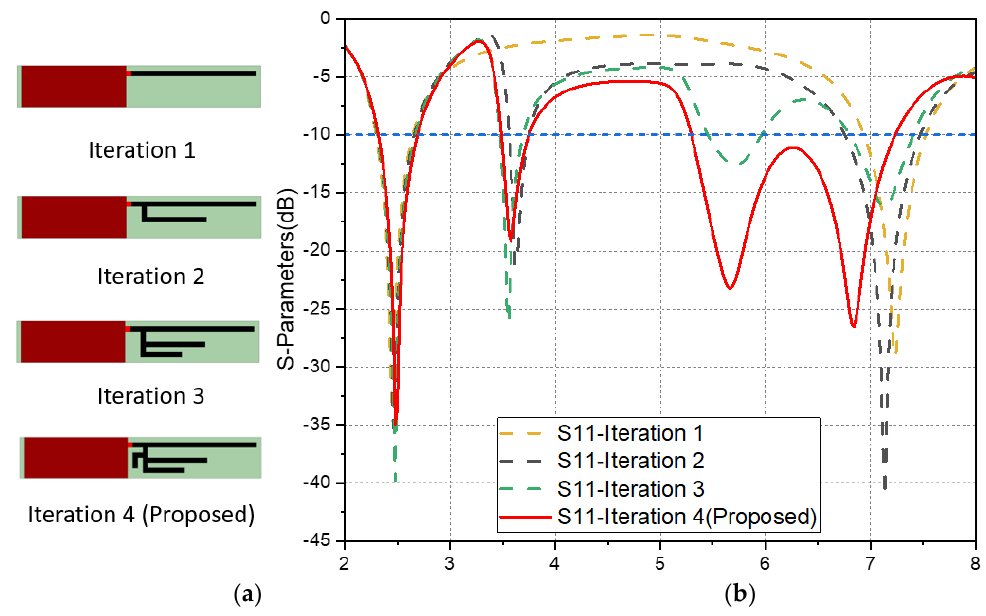
Figure 2. ( a ) Evolution steps of Ant. 1, ( b ) corresponding reflection coefficients (|S11|).